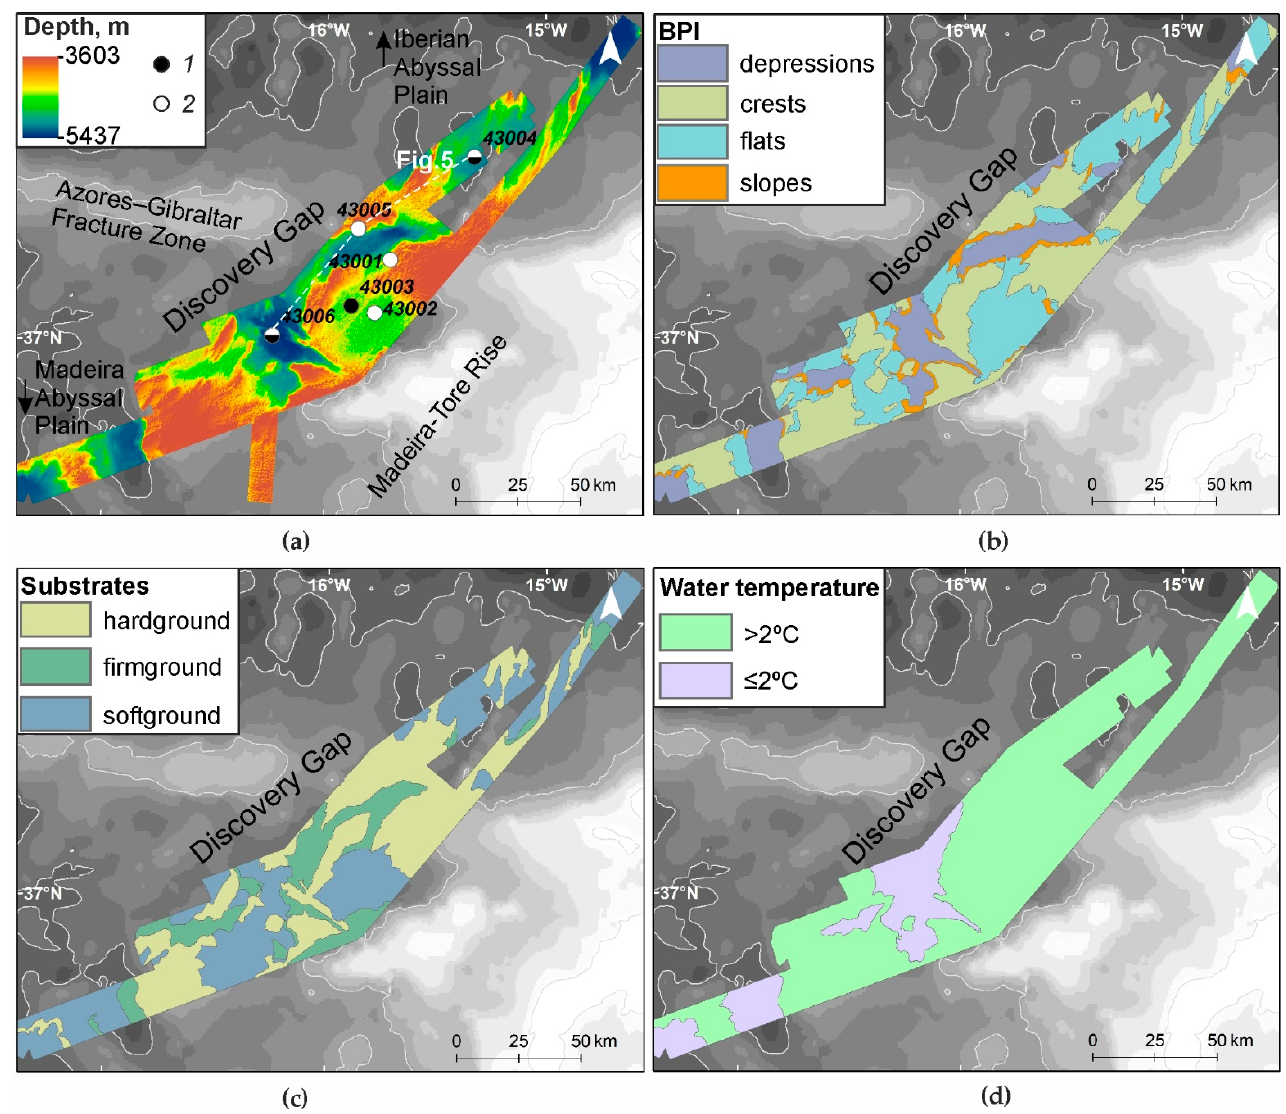
Figure 2. Seabed characteristics and near-bottom temperature used in the analysis: ( a ) multibeam bathymetry data, 1—sediment cores, 2—water column properties; ( b ) BPI zones; ( c ) substrate types; ( d ) water potential temperature.